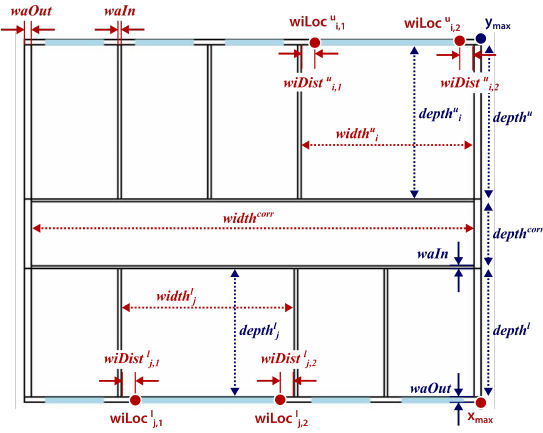
Figure 2: Illustration of the used model parameters and observa-